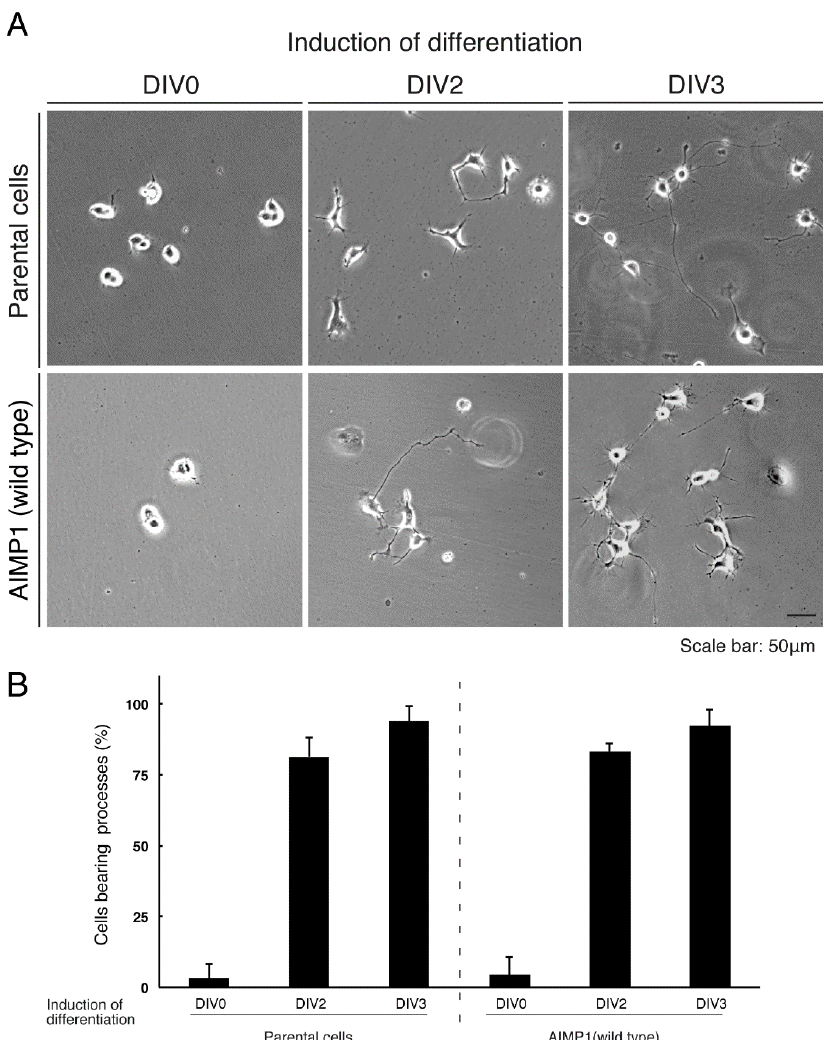
Figure 11. Cells harboring the wild type AIMP1 exhibit di ff erentiated phenotypes. ( A , B ) We allowed N1E-115 cells stably harboring the wild type AIMP1 construct or parental cells to di ff erentiate for 0, 2, or 3 days (DIV0, DIV2, or DIV3). The scale bar indicates 50 µ m. Percentages of di ff erentiated cells bearing neurite-like processes that were at least one cell body in length are statistically shown (n = 3 fields [total 240 cells]).